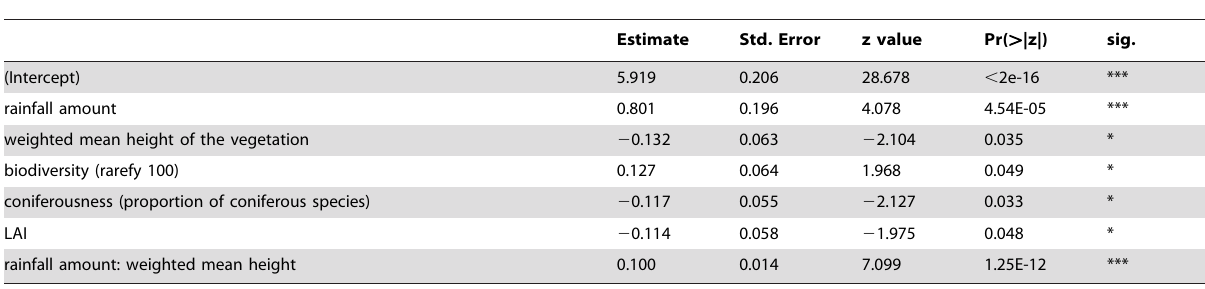
Table 2. Effects influencing throughfall kinetic energy (TKE).